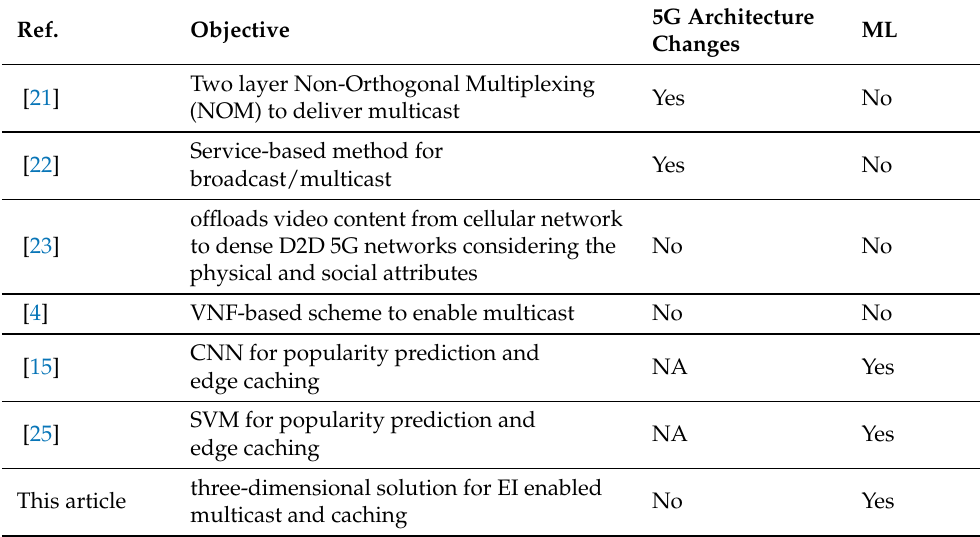
Table 1. Comparison of existing